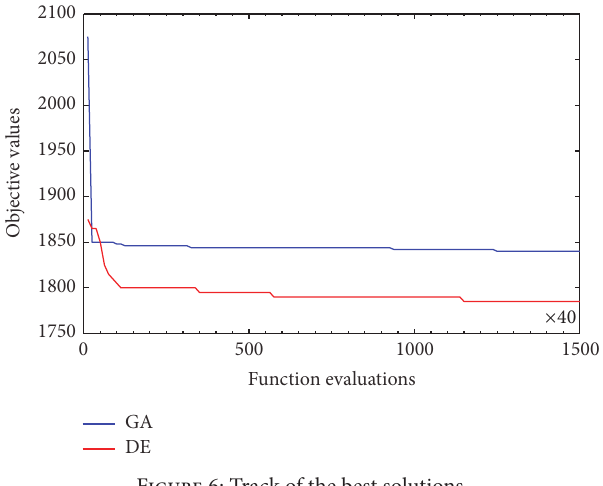
Figure 6: Track of the best